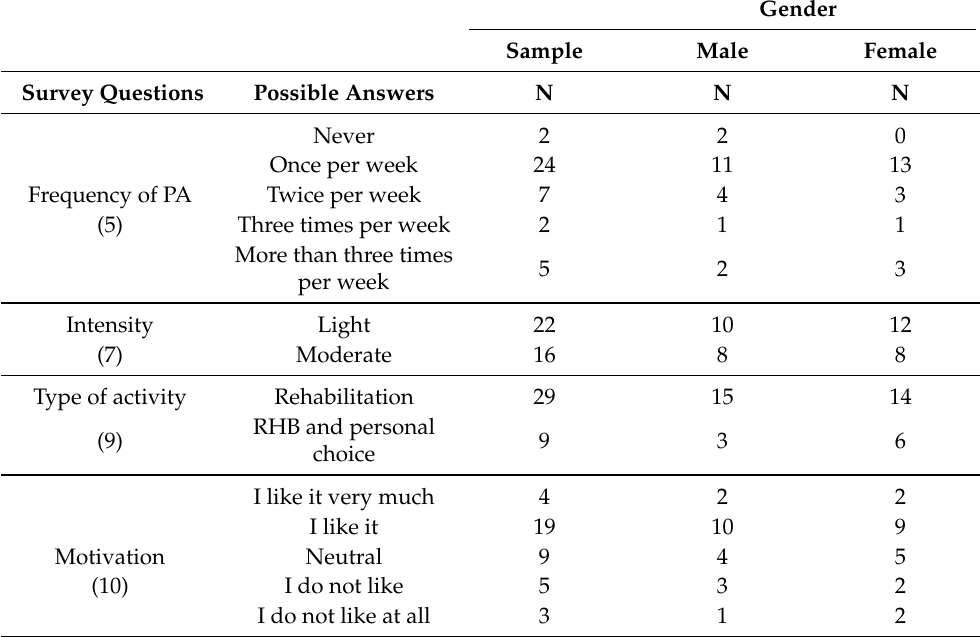
Table 5. Characteristics of PA routine followed by participants according to the survey questions (5, 7, 9 and 10).